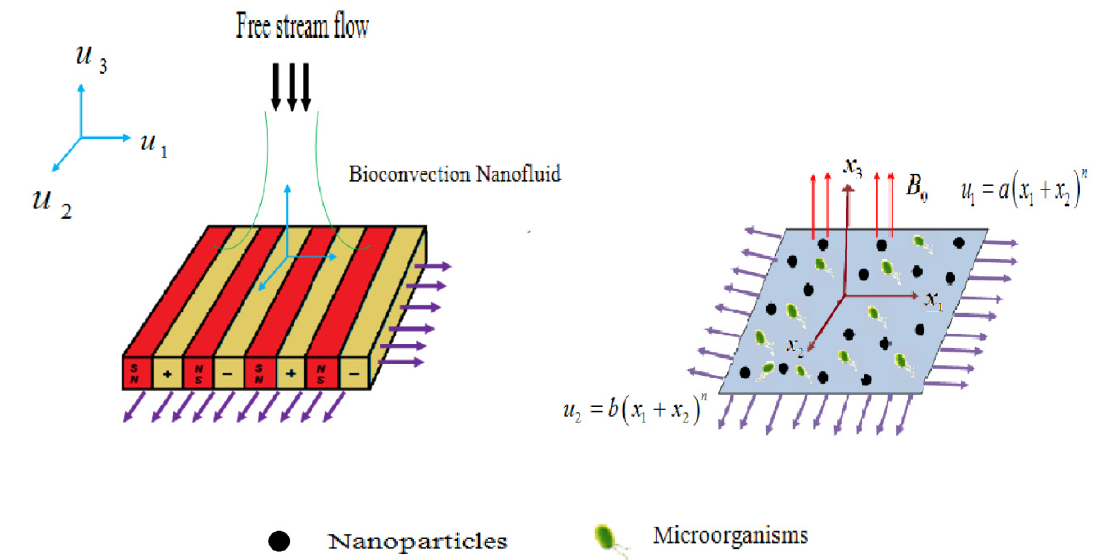
Figure 1. Geometry of the flow model.